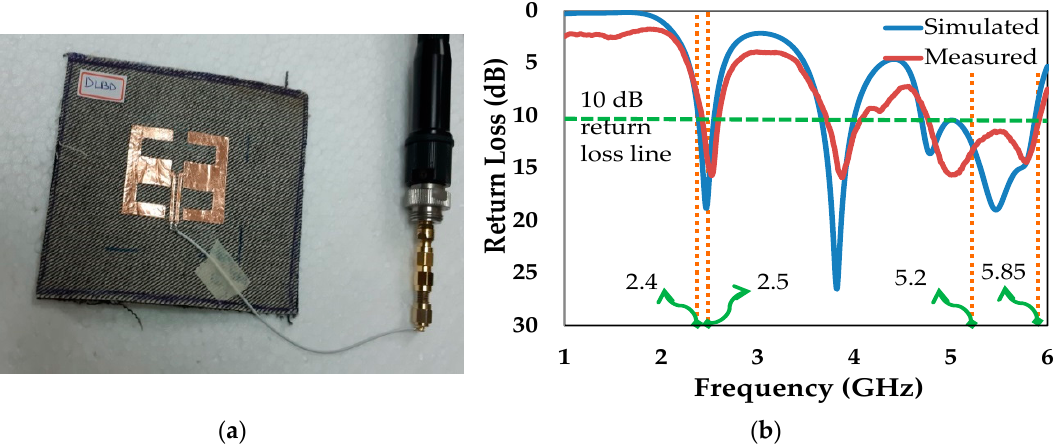
Figure 2. ( a ) Photo of the antenna prototype connected to the network analyser using a minicoaxial cable; ( b ) Comparison of simulated and measured return loss in free space.